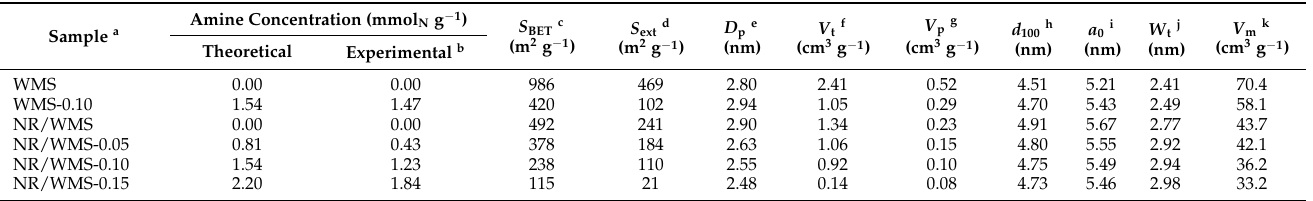
Table 2. Physicochemical properties of pure silica WMS, NR/WMS and NR/WMS-NH 2 materials synthesized under various conditions.